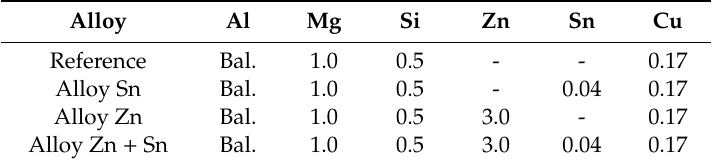
Table 1. Composition of experimental alloys in wt